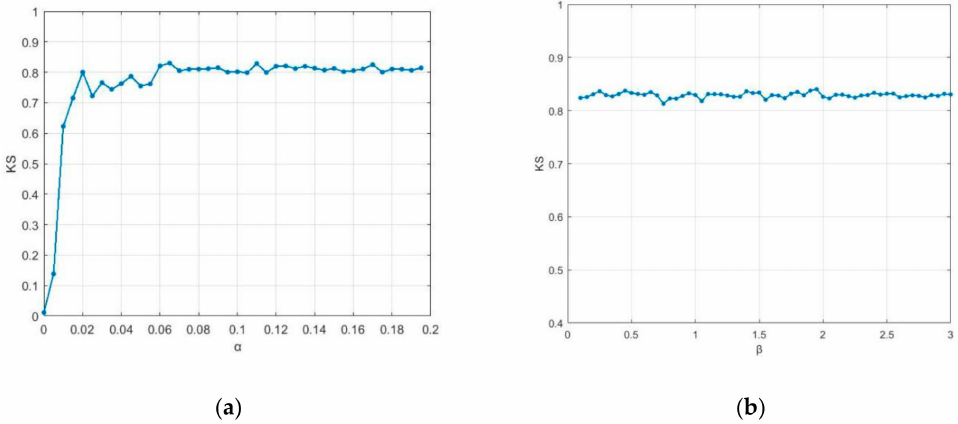
Figure 4. Sensitivity analysis of α and β . ( a ) The sensitivity analysis of α ; ( b ) the sensitivity analysis of β